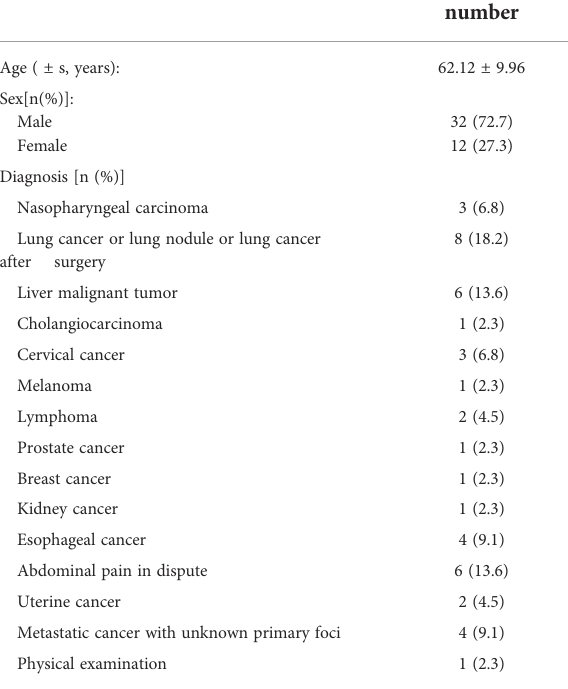
Basic information